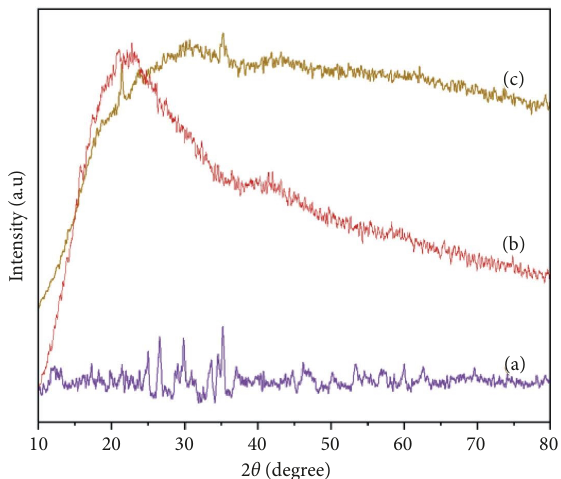
Figure 6: X-ray difraction patterns of (a) Cu(II), (b) Co(II), and (c) Fe(II) complexes.